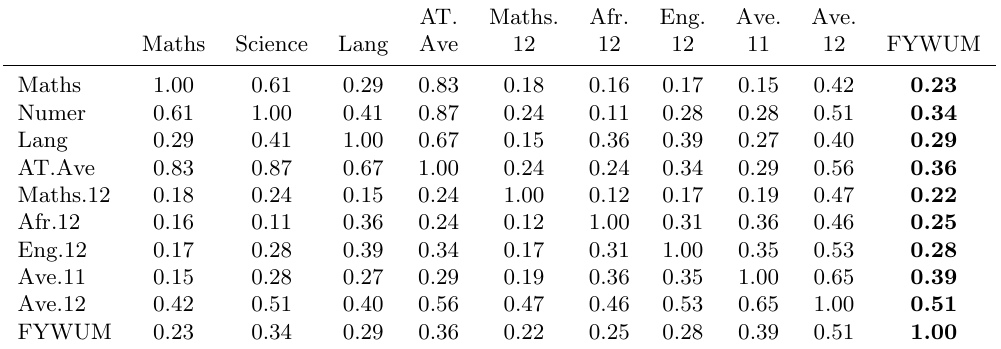
Table 12: Inter-correlations among the Test Battery 2 variables – 2001 [Critical r = 0 . 11 (5% significance level), 0.15 (1% significance